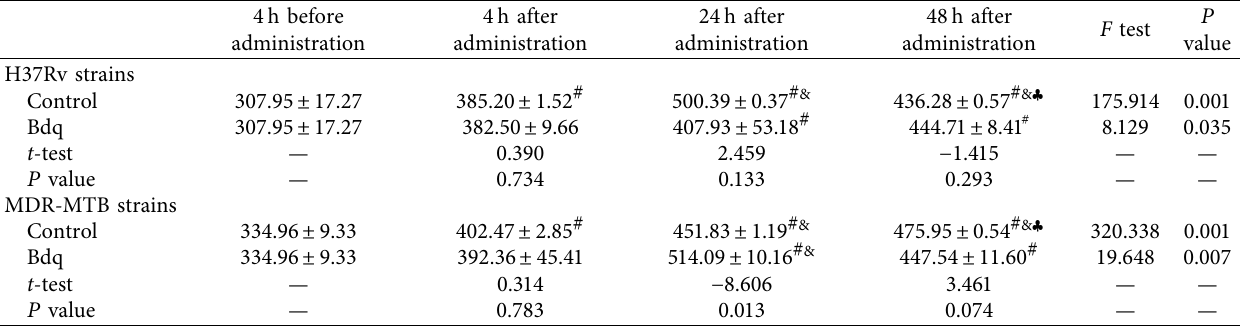
Table 4: Levels of TNF- α in culture supernatants of macrophages infected with H37Rv and MDR-MTB strains after Bdq administration (pg/ ml, x ± s ).